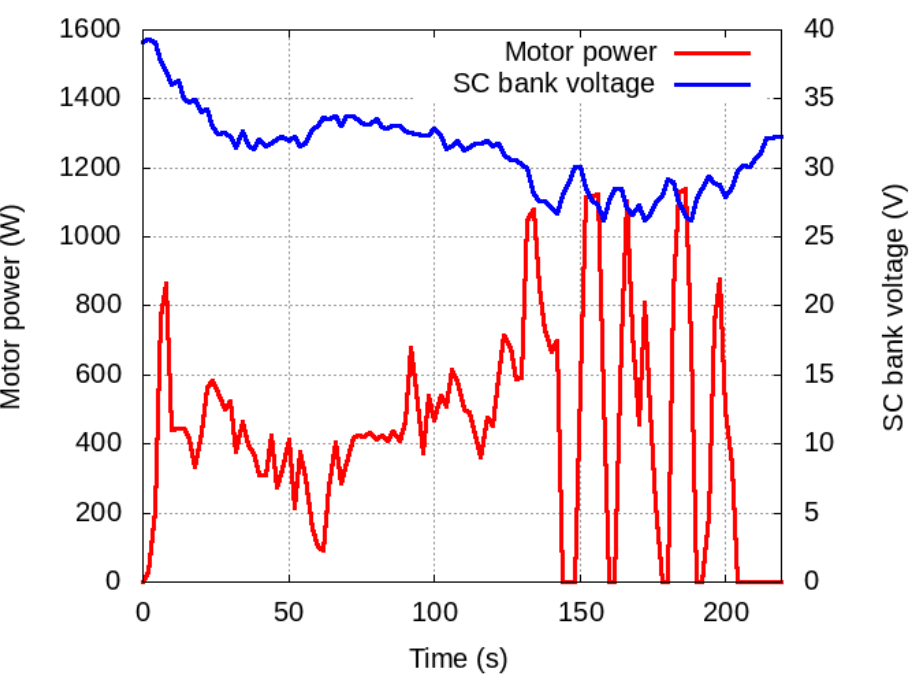
Figure 8. Power and SC voltage diagram, created from data logged during the 1st lap of the Shell Eco-marathon Europe